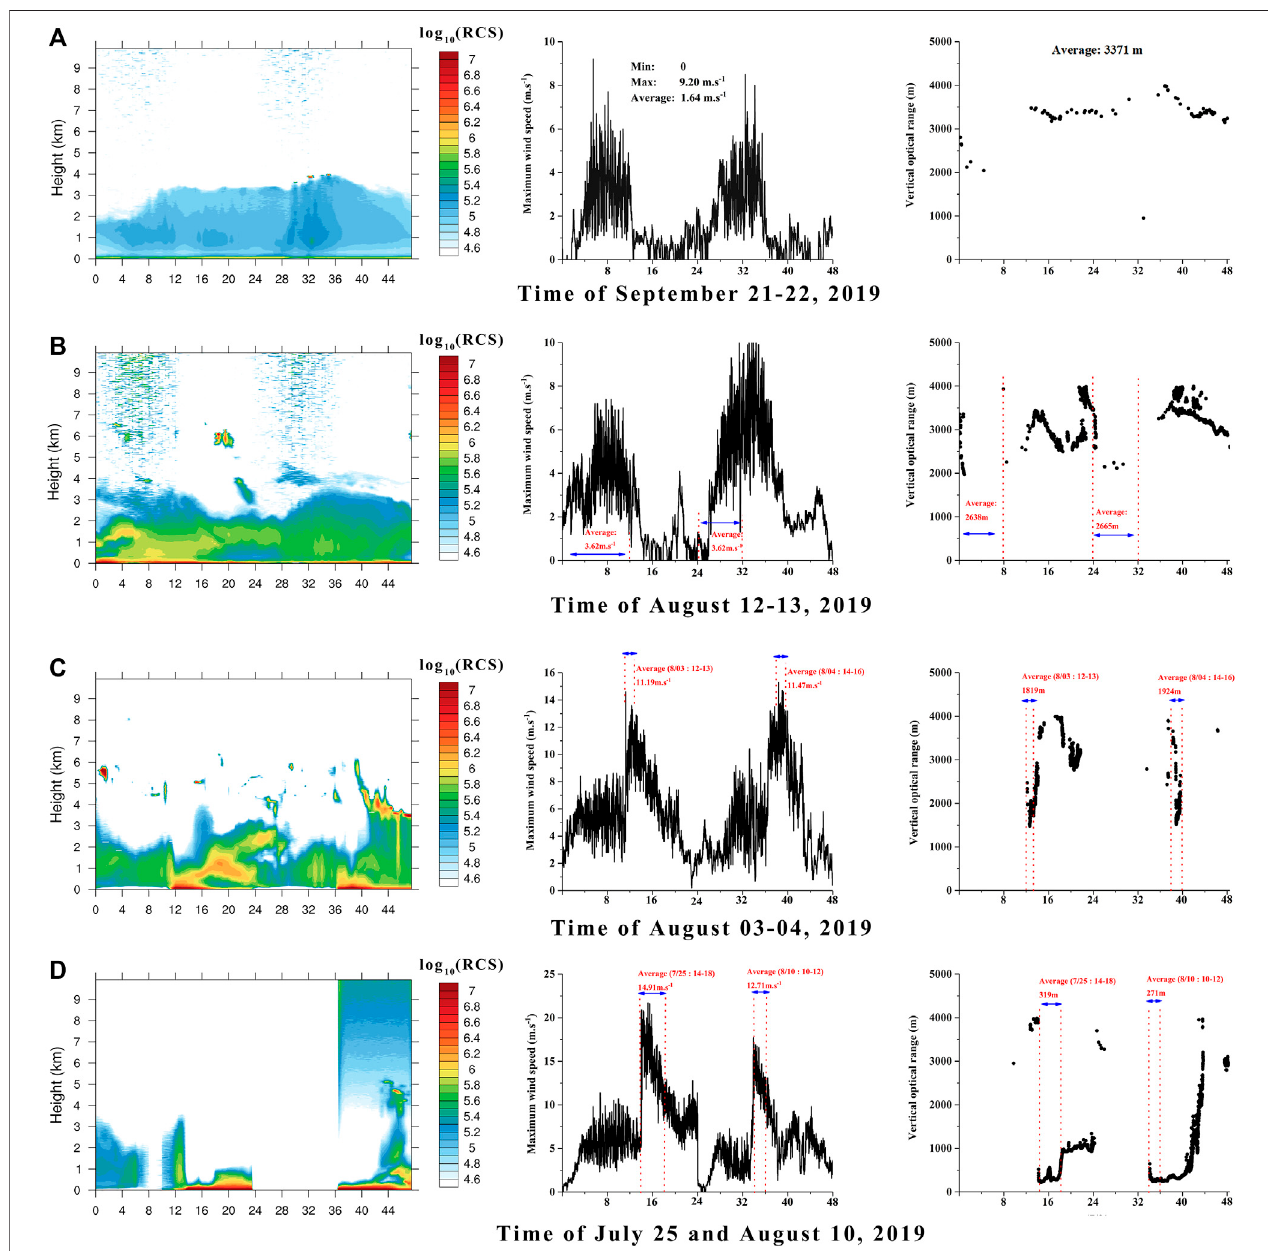
FIGURE 9 | Left panels: vertical pro fi les of 30-min averaged log 10 (RCS) from the ceilometer. Middle panels: time series of instantaneous maximum surface wind speed (ms − 1 ) with 1-min resolution. Right panels: time series of vertical optical range (in m) from the ceilometer. The mean values are shown in the fi gures. (A) Clear-sky days arefrom September 21to22,2019. (B) Floatingdustydays arefromAugust 12to13,2019. (C) Blowing dustydays arefromAugust 3to4, 2019. (D) Strongdust storms are on July 25 and August 10, 2019.